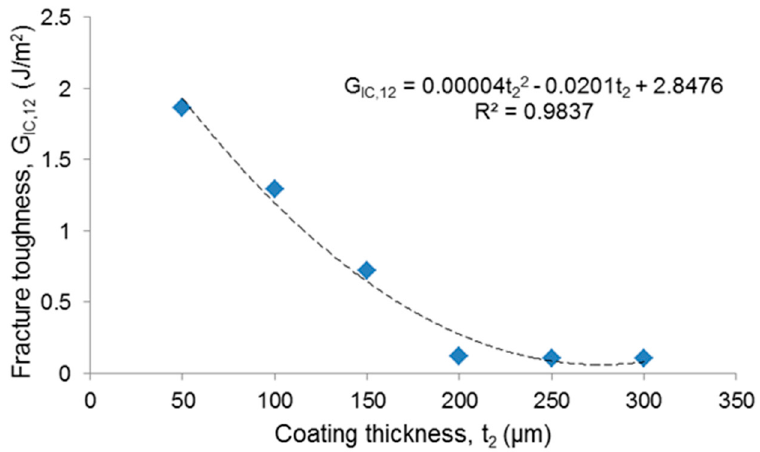
Figure 6. Relationship between fracture toughness and coating thickness (blue points: experimental values, dashed line: fitting curve).